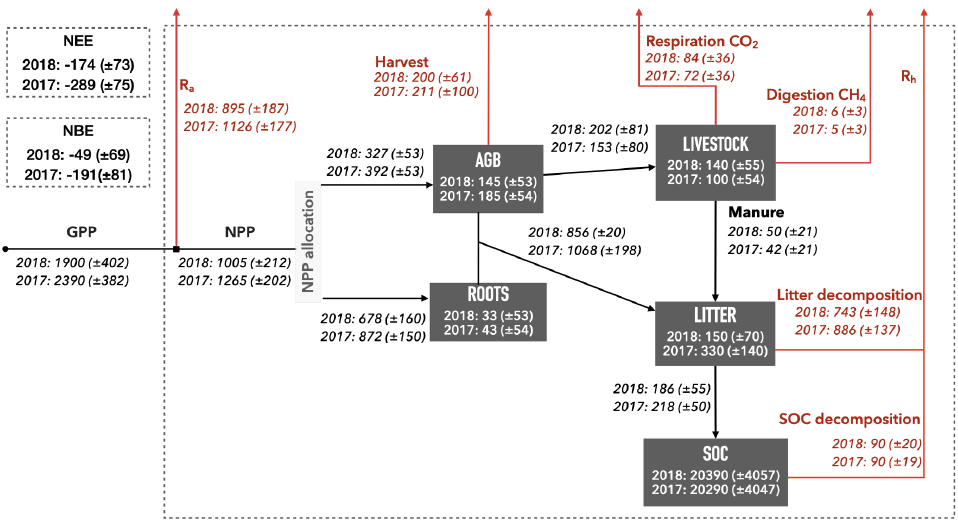
Figure 6. Spatial mean ( ± standard deviation) of the estimated C pools and fluxes across the 1855 simulated fields for 2017 and 2018. NEE (net ecosystem exchange) and NBE (net biome exchange) for 2017 and 2018 also presented. Internal ecosystem fluxes are presented as black arrows. Fluxes towards the atmosphere are presented as red arrows. Fluxes values show cumulative gCm − 2 yr − 1 and pool values show average gCm − 2 yr − 1 . For a schematic of the DALEC-Grass model and all the modelled C pools and fluxes, see Fig.